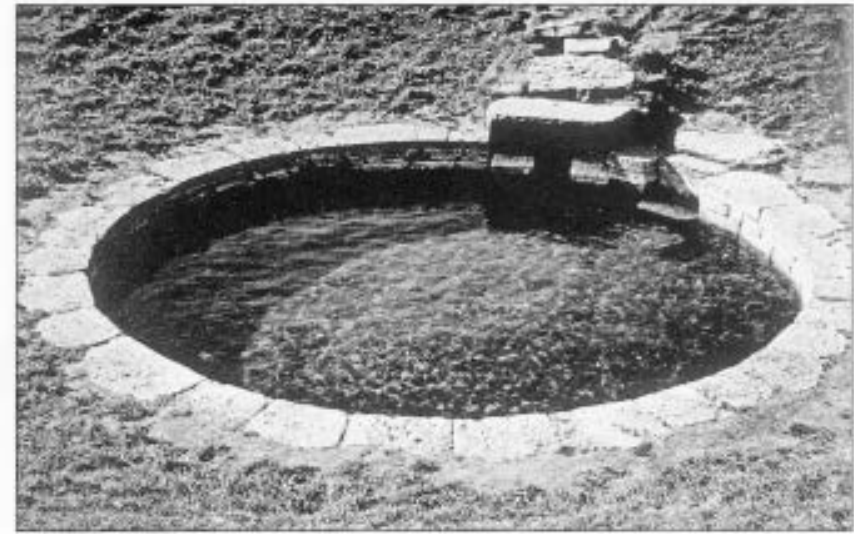
Figure 5 View northeast of the reconstructed warm-water bath Snorralaug at Reykholt (diameter of the bath c. 4m).